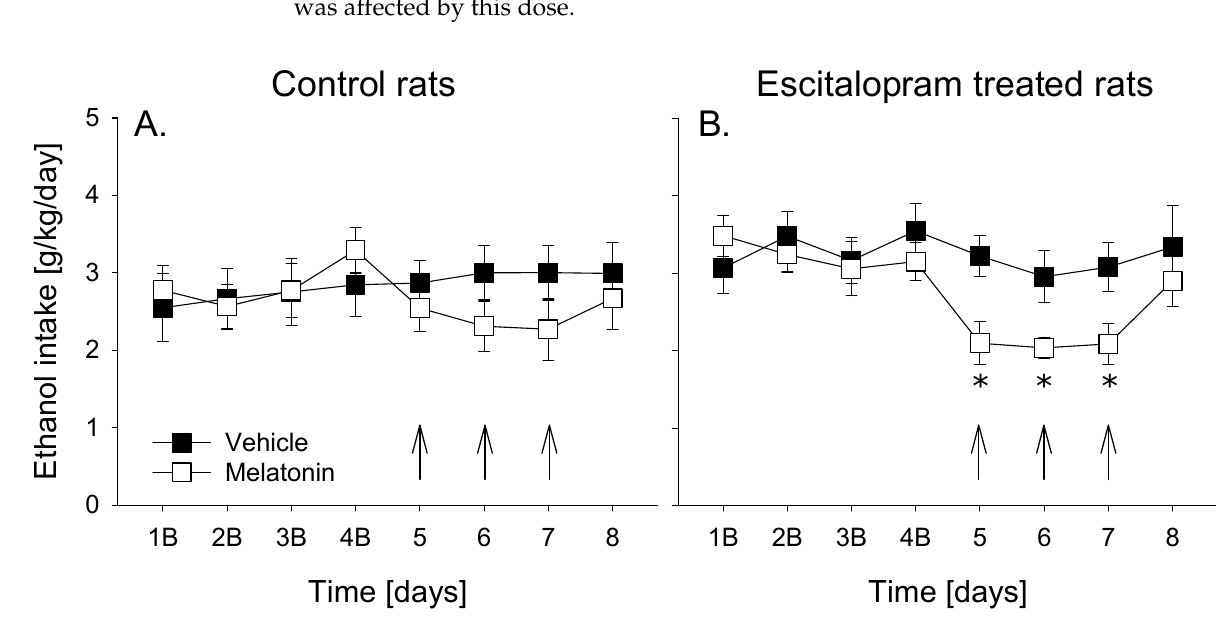
Figure 3. Total daily ethanol (in g of pure ethanol per kg of body weight per 24 h, g/kg/day, A , B ) intake in control ( A , n = 10) and escitalopram treated ( B , n = 8) male rats before (baseline, 1B, 2B, 3B and 4B), during (arrows) and after administration of either vehicle or 40 mg/kg of melatonin. Drug administration was performed once daily during three consecutive days at the end of the light phase. Data are presented as means ± S.E.M. * indicates significant differences from vehicle treatment, p < 0.05.